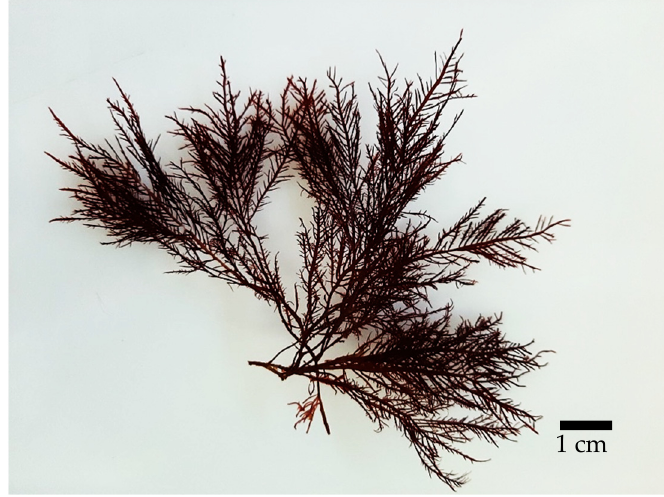
Figure 1. Macroscopic image of Gelidium corneum collected in Centre Portugal.